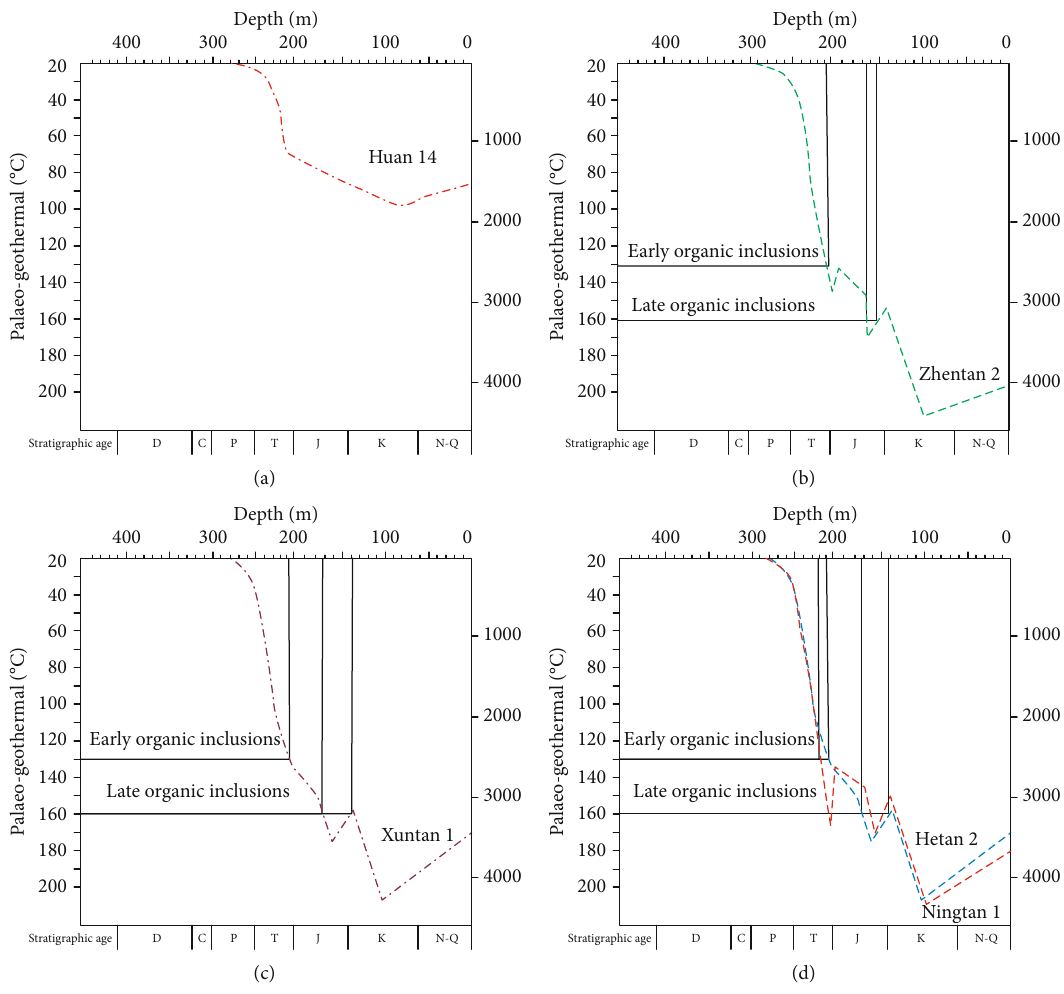
Figure 11: Natural gas accumulation time of the Upper Paleozoic in the study area recorded by fl uid According to the results of inclusion homogenization temperatures, the low temperature (120 ° C -130 ° C) inclusions are the fi rst-stage inclusions, which are distributed in the early fi ssures or dissolution pores. They belong to hydrocarbon inclusions in the initial gas migration to the reservoir, and some inclusions have fl uorescence. The high-temperature inclusions (150 ° C-160 ° C) are the second-stage inclusions, belonging to the non fl uorescent natural gas inclusions formed during the massive gas migration and accumulation in the tec- tonic uplift stage. Considering the gas “ window ” is Ro = 1 : 30 % for the Upper Paleozoic source rocks in the southwest of Ordos Basin, large-scale gas generation could only occur when the paleogeothermal temperature was higher than 170 ° C. However, the paleogeothermal temperature of the Upper Paleozoic in the Huan 14 well did not reach this temperature (Figure 11(a)), so the thermal evolution of the Upper Paleo- zoic in the Huan 14 well did not enter the gas production stage. In other tectonic units, the paleogeothermal tempera- tures all reached the hydrocarbon generation windows, and hence, the intersections of early inclusion homogenization temperatures and the burial curves represent the formation time of hydrocarbon source rocks in the Upper Paleozoic.